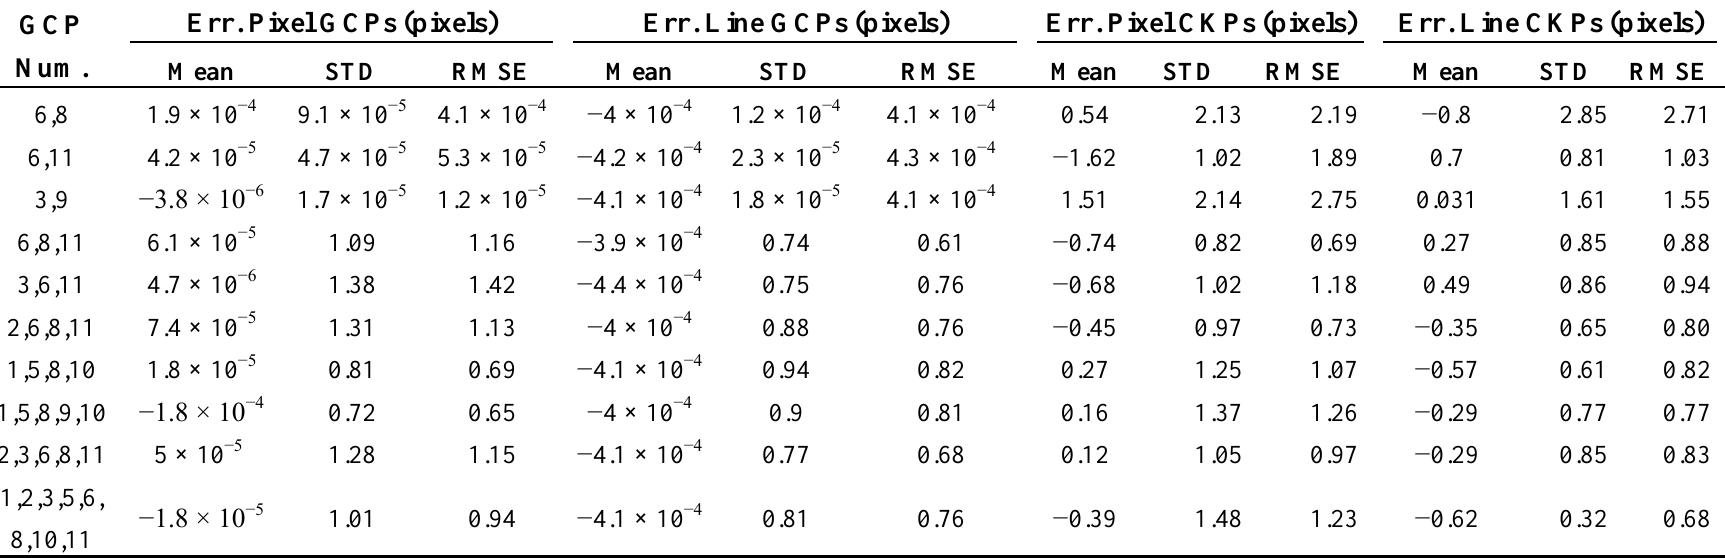
Table 3. The results of rational polynomial coefficient (RPC) adjustments by using synthetic aperture radar (SAR) sensor orientation correction in different ground control point (GCP) scenarios. The locations of points listed in column 1 are shown in Figure 2. CKP: check point, STD: standard deviation, RMSE: root mean square